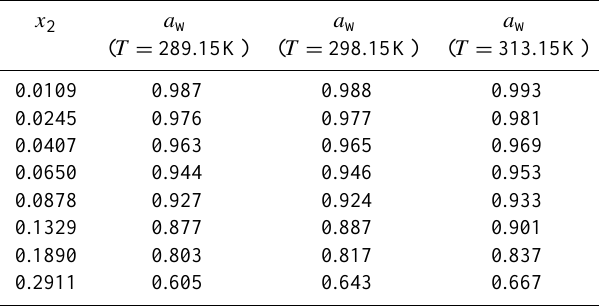
Table A4. Bulk water activity (a w ) measurements a of water (1) + 1,2,7,8-octanetetrol (2) solutions at three different temperatures. Solution compositions are given in mole fraction of the organic component (2), x 2 . x 2 a w a w a w ( T = 289 . 15K)